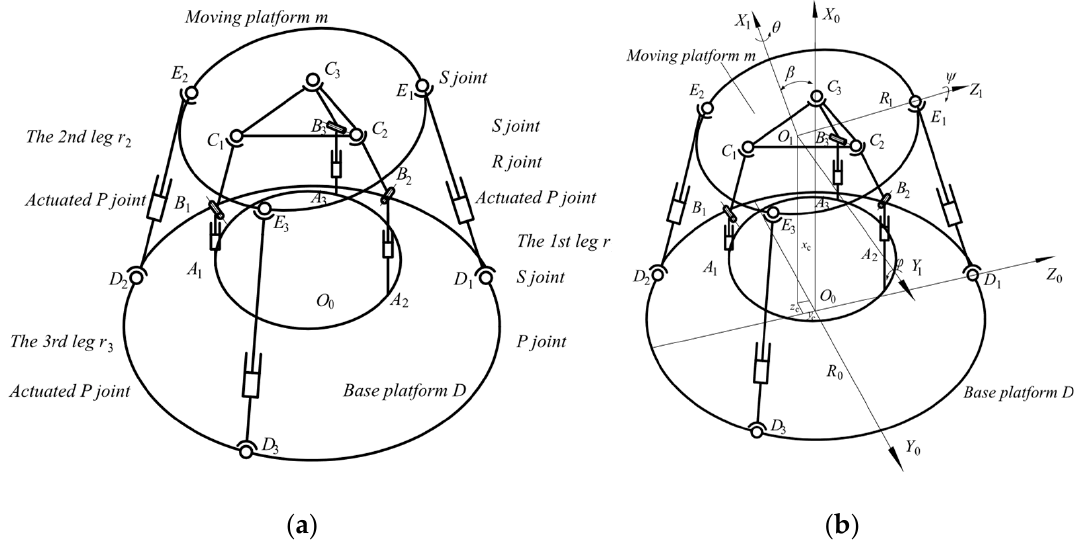
Figure 2. ( a ) The mechanism architecture of the 3SPS + 3PRS PM; ( b ) Frames of reference. On the base platform, D , D O as a center point and R 0